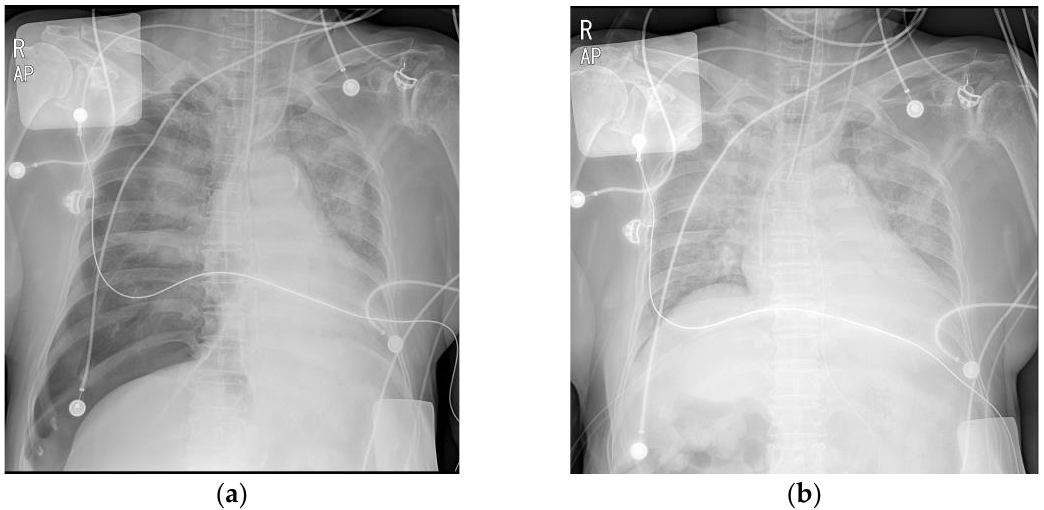
Figure 3. ( a ) The right lung field showed tension pneumothorax in the operating room. ( b ) After the tube thoracotomy, the pneumothorax was improved.